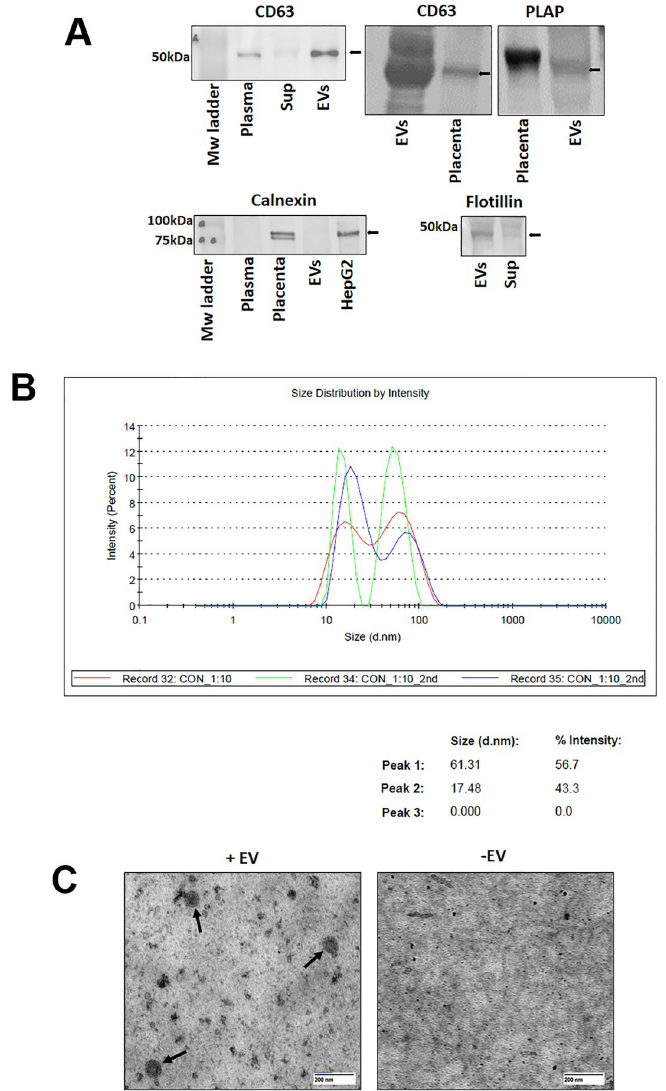
Fig 1. Characterization of plasma EVs (EVs). A. Immunoblot showing enrichment of CD63 (~60 kDA) in EVs compared to plasma, supernatant (Sup), and placenta and enrichment of placental-specific placental alkaline phosphatase (PLAP; ~70 kDA) (top panel). Immunoblot showing absence of cell-specific marker Calnexin (~90 kDA) in EV and plasma samples and presence in placenta and HepG2 cell line (bottom left panel) and enrichment of flotillin, an EV-specific marker in EVs compared to plasma. B. Size distribution and intensity of EVs detected by dynamic light scattering (red, green, blue peaks represent replicates) with table below showing the average size and intensity. C. Representative transmission electron microscopy of EVs (+EVs) with a negative control (-EVs), scale bar = 200 nm. Black arrows demonstrate the